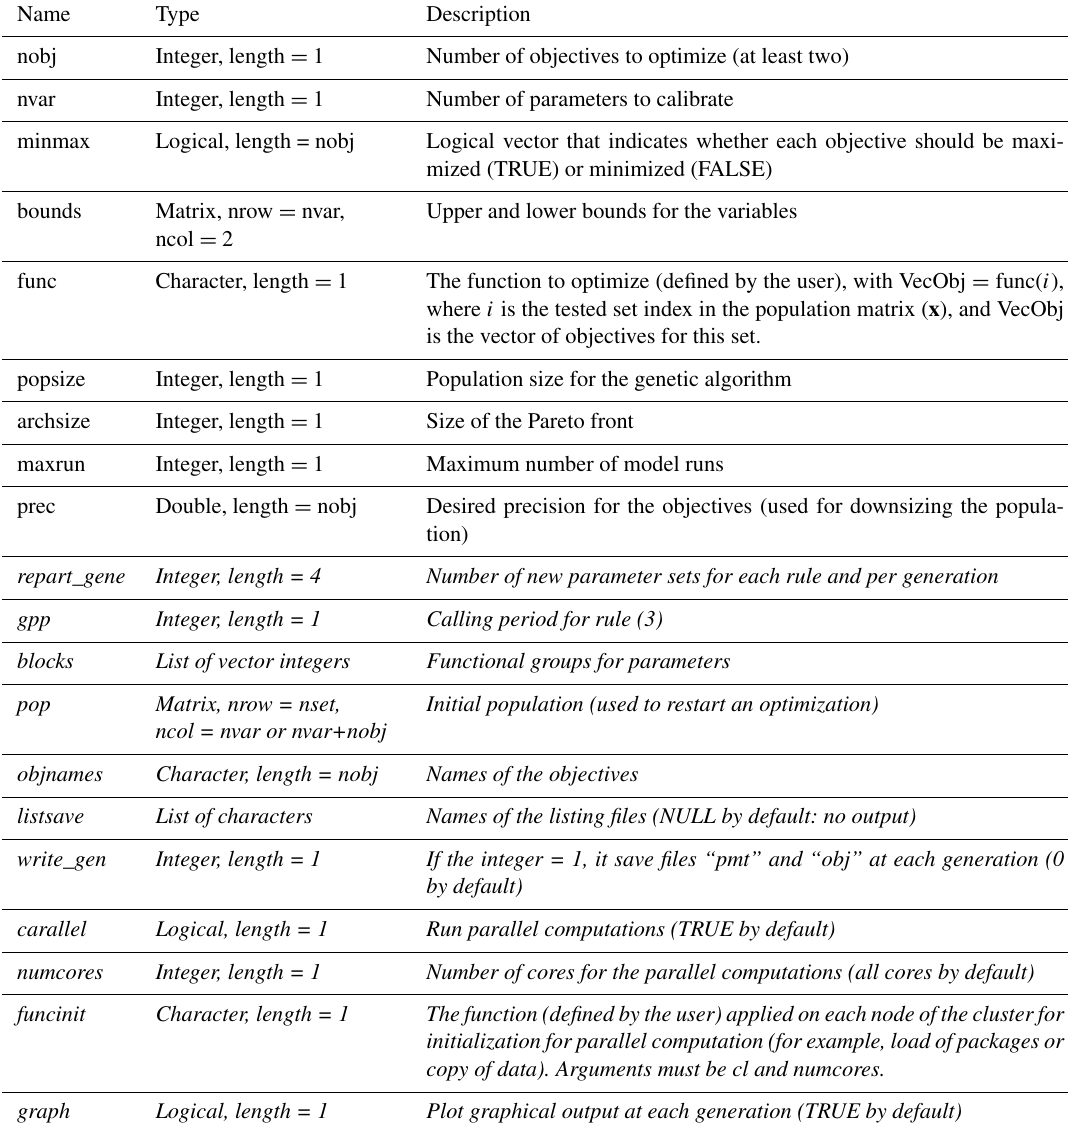
Table A1. Arguments of the caRamel() function. Optional arguments are shown in italic